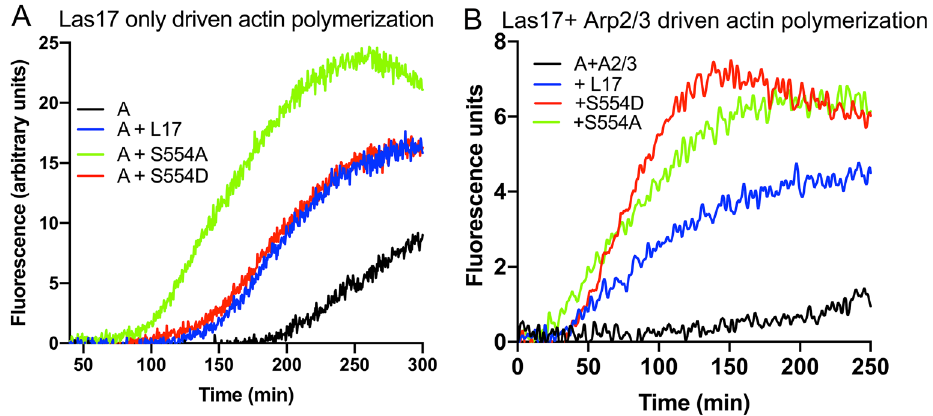
Figure 2. The effect of Las17 S554 mutations on actin polymerization in vitro. 0.5 µM 5% pyrene labelled actin was polymerized in the presence of G-buffer plus 0.5 × KME as described in the absence ( A ) or presence ( B ) of 5 nM Arp2/3. The effect of a Las17 fragment (amino acids 300–633) either wild-type or with an S554A or S554D mutation was investigated. Experiments were repeated at least three times and representative traces are shown. Analysis of significant differences was carried out using Uncorrected Dunn’s test and showed that in the absence of Arp2/3 the lag phase for nucleation by S554A is significantly reduced to about 40% of wt and S554D Las17 lag phase times ( p = 0.0447, and 0.0180 respectively). In the presence of Arp2/3 the lag phase for nucleation with S554A is reduced compared to that of wt ( p = 0.0153) There is no significant difference between the lengths of the lag phases for S554A and